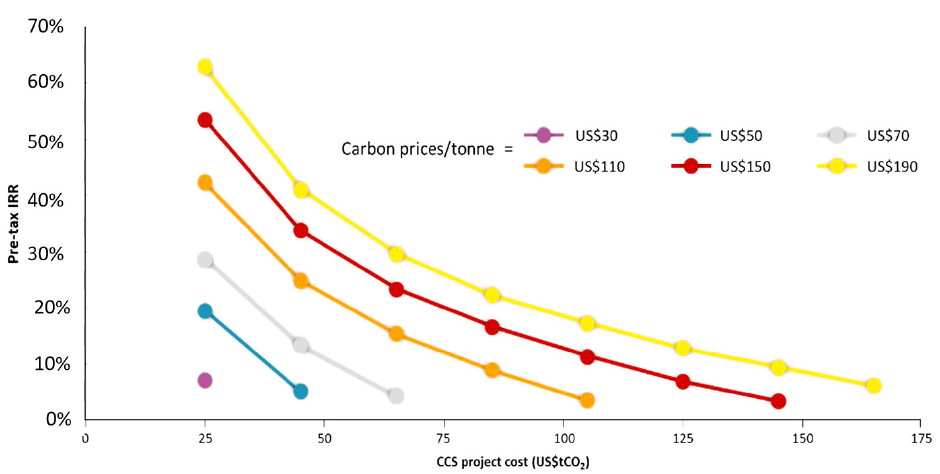
Fig. 26. – CCS project costs vs. pre-tax-Internal Rate of Return. The current carbon price ( < 30 $/ton) hinders the economic viability of any CCS project